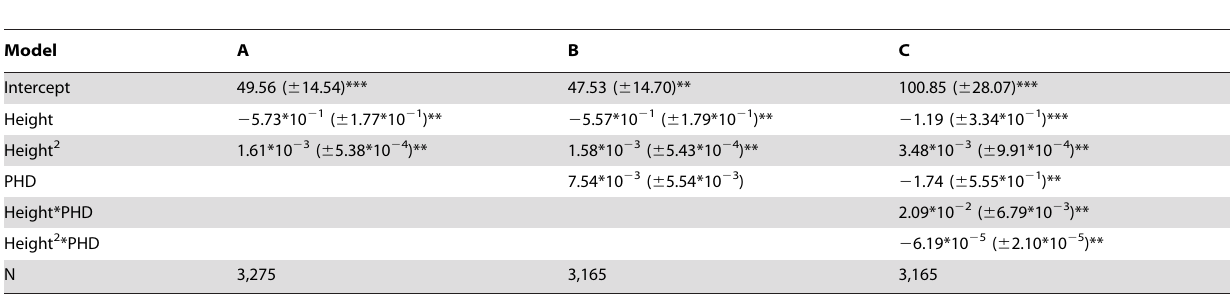
Table 5. Logistic regression parameter estimates ( 6 s.e.) of the effects of maternal height, height 2 , parental height differences and their interactions on the probability of an emergency Caesarean